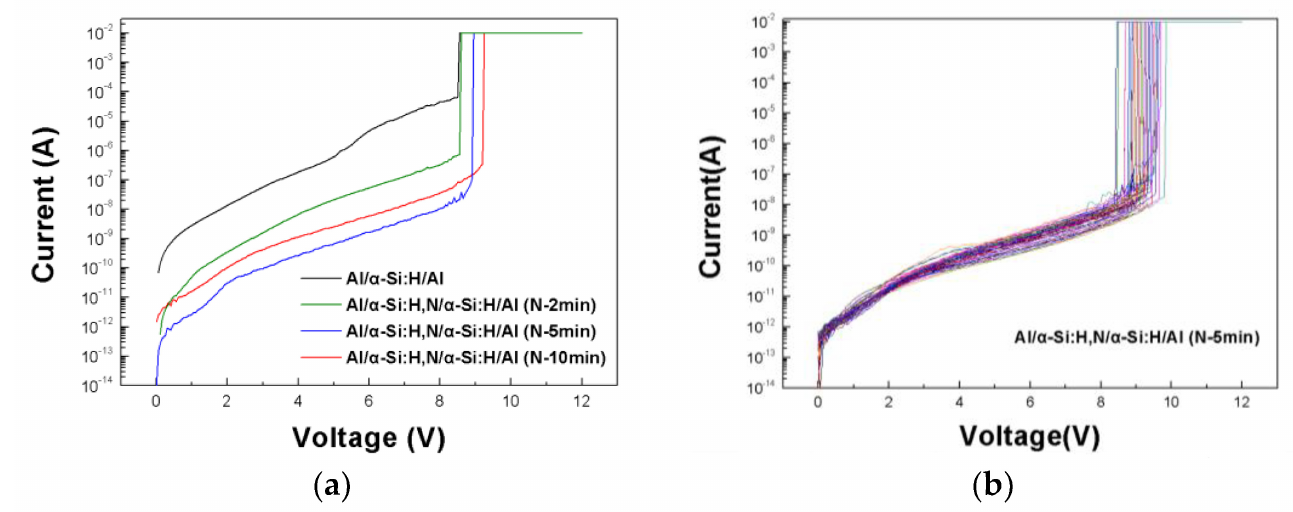
Figure 4. I–V curves: ( a ) the Al/ α -Si:H/Al antifuse and Al/ α -Si:H,N/ α -Si:H/Al serial antifuses with dielectric films treated by nitrogen plasma for different time; ( b ) the statistics properties of Al/ α -Si:H,N/ α -Si:H/Al (N-5min) antifuse with dielectric films treated by nitrogen plasma for 5 min. The leakage current increased monotonously with increasing voltage; then, the current increased sharply to the current limit at the breakdown voltage. During the process of breakdown, the conductive filament was formed in the antifuse device at high